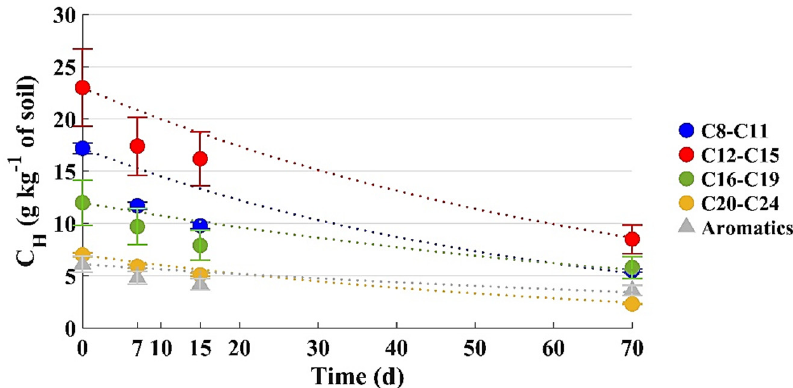
Figure 5. First-order model. Relative standard deviation range: 2.79—14.95%. Table 4. First-order reaction rate constants and half-life times.